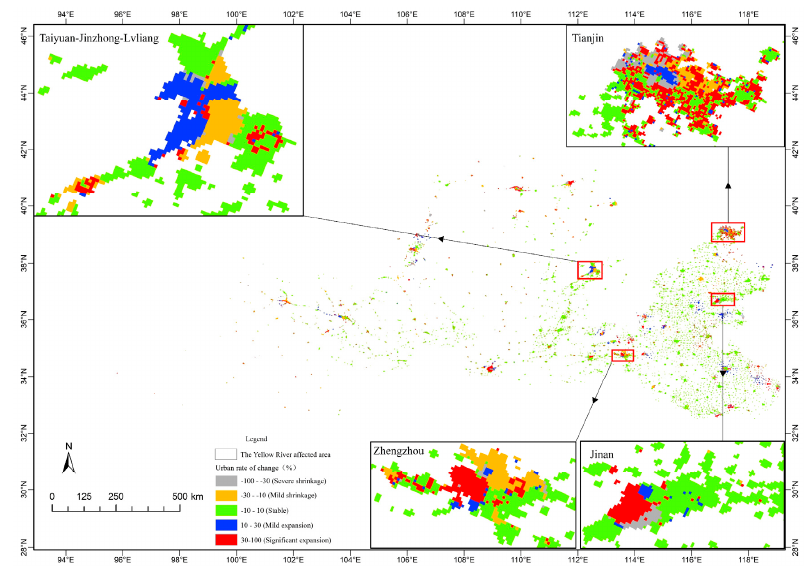
Figure 6. Spatial distribution of natural city shrinkage and expansion in the Yellow River affected area. ( a ) Shrinking and expanding cities with the shrinking and expanding ratio in nightlight data; and ( b ) Shrinking and expanding cities with the shrinking and expanding ratio in population data. Meanwhile, compared with the results calculated by Landscan population data dur- ing the same period (Figure 6b), there is a difference between the number of shrinking and expanding cities and the results obtained by NPP-VIIRS data. The number of shrink- ing and expanding cities identified by NPP–VIIRS night light data are more than those identified by LandScan population data (Figure 7). Comparing the results of night light data and Landscan population data, we can see that the number of shrinking and expand- ing cities identified by population data is less than that by night light data, and the number of basically stable cities is more than that of night light data.